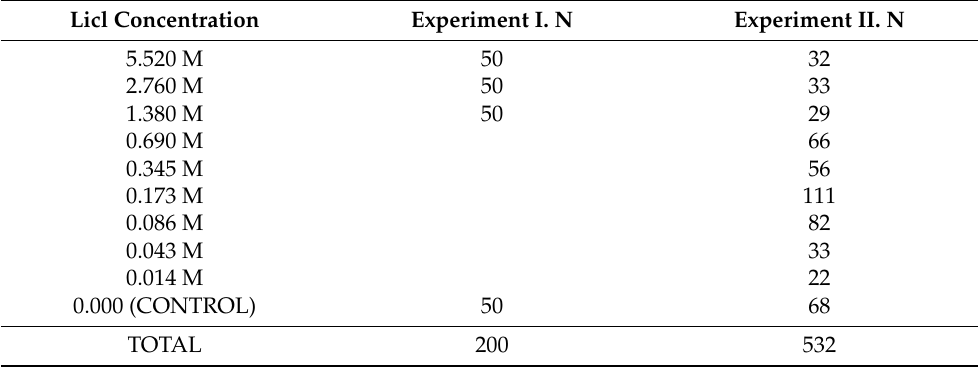
Table 1. The number of mites tested (N) in Experiments I. and II. Licl Concentration Experiment I. N Experiment II.